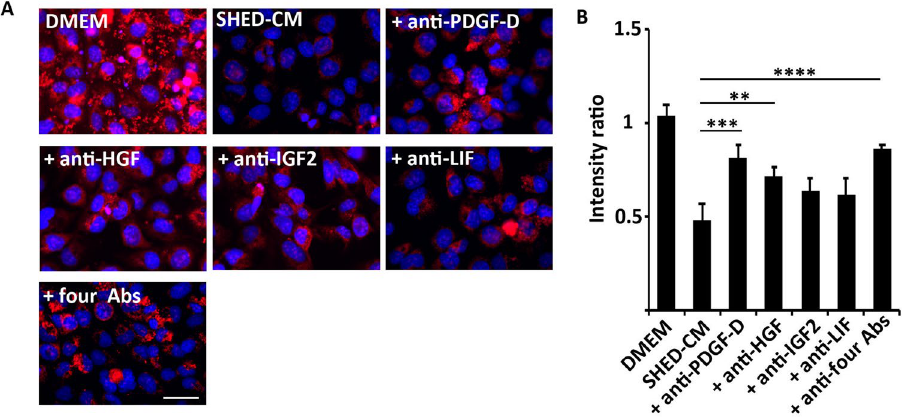
Figure 9. Antioxidant effect of enriched proteins in SHED-CM. ( A ) Representative immunofluorescence images of MitoSOX analysis with nuclear DAPI staining of human acinar cell line 24 h after irradiation. Scale bar: 100 μm. ( B ) Quantitative analysis of the fluorescence intensities of MitoSOX analysis. The average fluorescence intensities were significantly higher in the irradiated cells treated with SHED-CM together with anti-PDGF-D antibodies or anti-HGF antibodies than those treated with SHED-CM alone. The antioxidant effect of SHED-CM was most strongly inhibited after treatment with four neutralizing antibodies together. Comparisons between groups were analyzed using an ANOVA with Tukey’s multiple comparison test. Data are represented as mean ± SD (** p < 0.01, *** p < 0.001). CM, conditioned medium; HGF, hepatocyte growth factor; Fibro, fibroblast; PDGF, platelet-derived growth factor; SHED, stem cells from human exfoliated deciduous